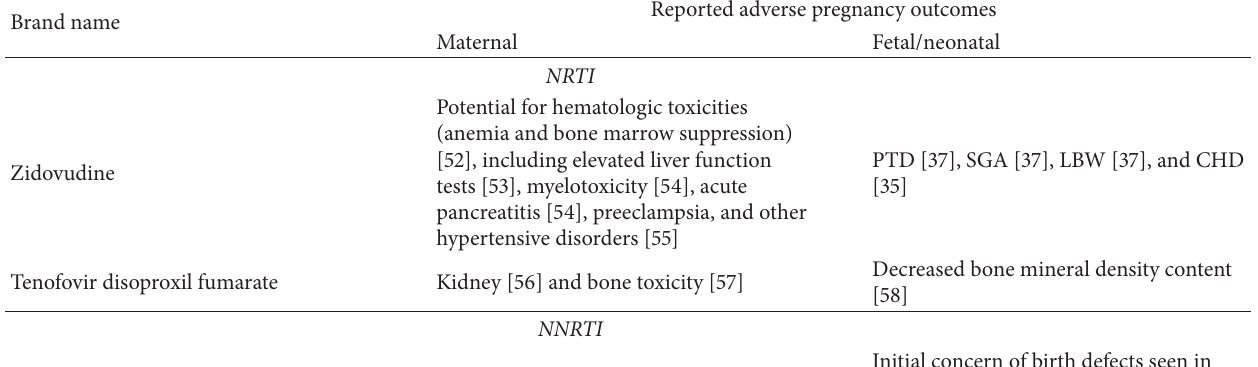
Table 3: Pregnancy outcomes of individual antiretroviral agents during pregnancy ∗ .